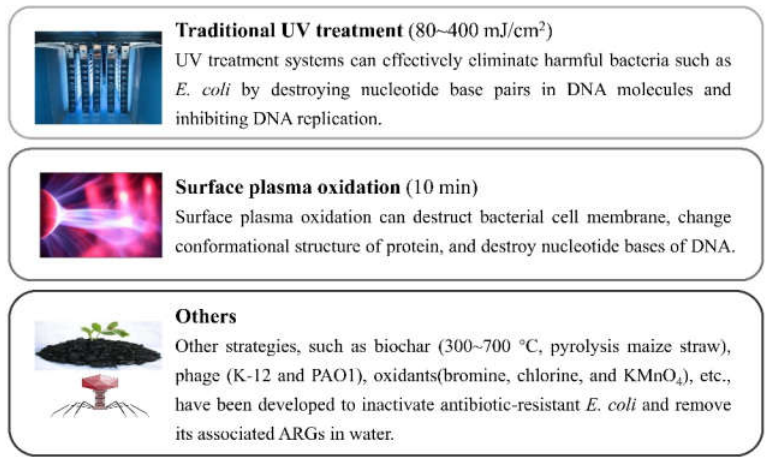
Figure 2. Strategies to eliminate AR E. coli and its